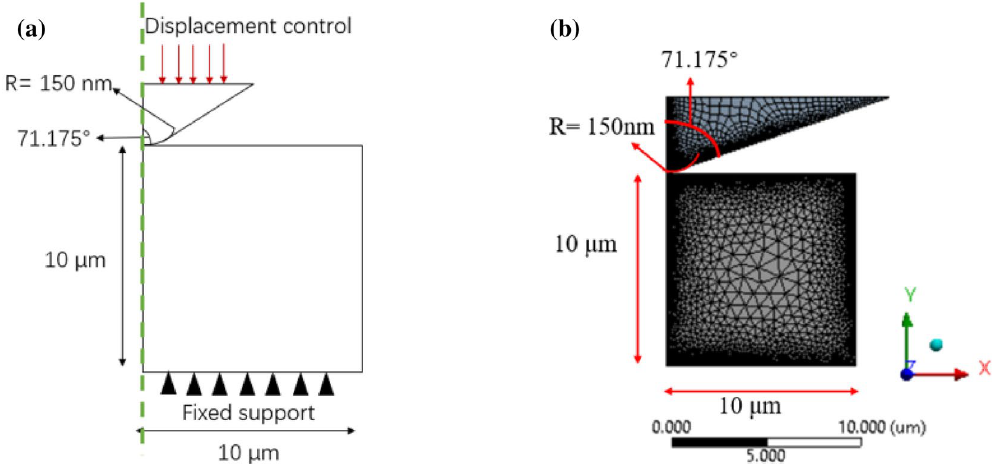
Figure 10. ( a ) 2-D axisymmetric indentation model illustrate a round tip indenter loading on a shale sample which fixed at the bottom. ( b ) Mesh of the specimen with the indenter produced by using Ansys software 26 (ANSYS-Academic V19.2, https:// www. ansys. com/ acade mic/ stude nts).